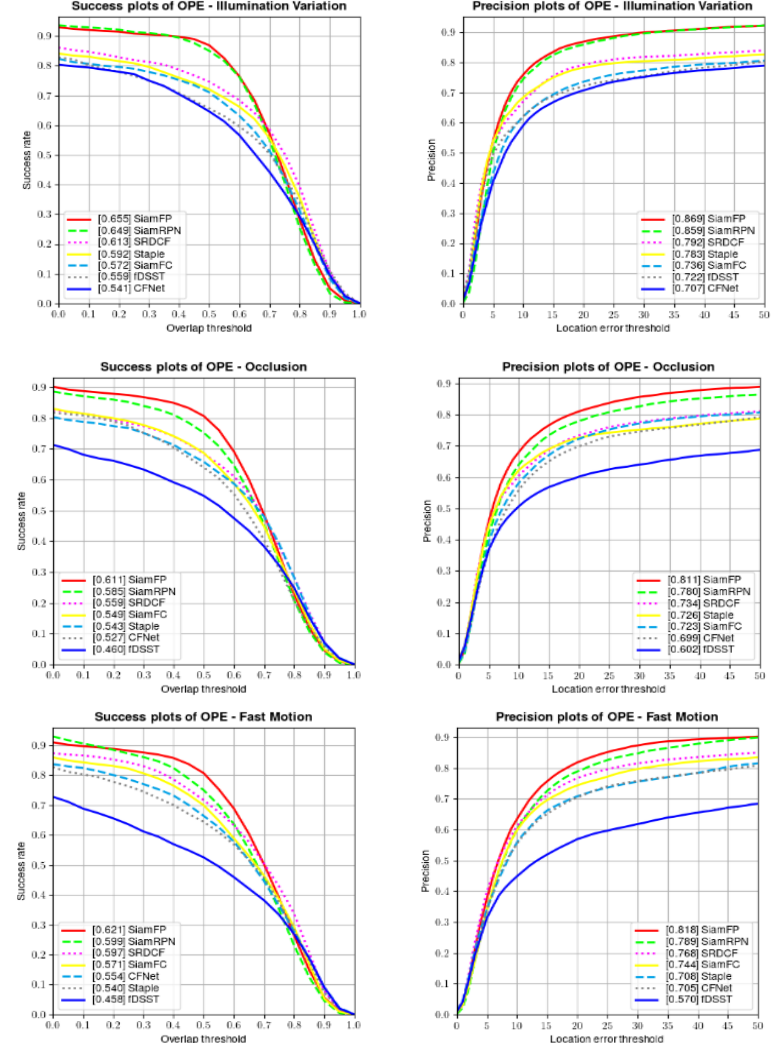
Figure 5. The Success Plots and Precision Plots on OTB2015 Dataset with Three Attributes.